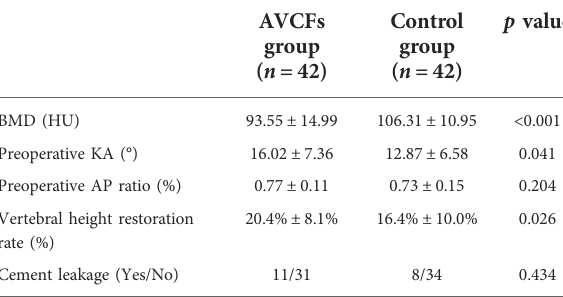
TABLE 6 Univariate analysis